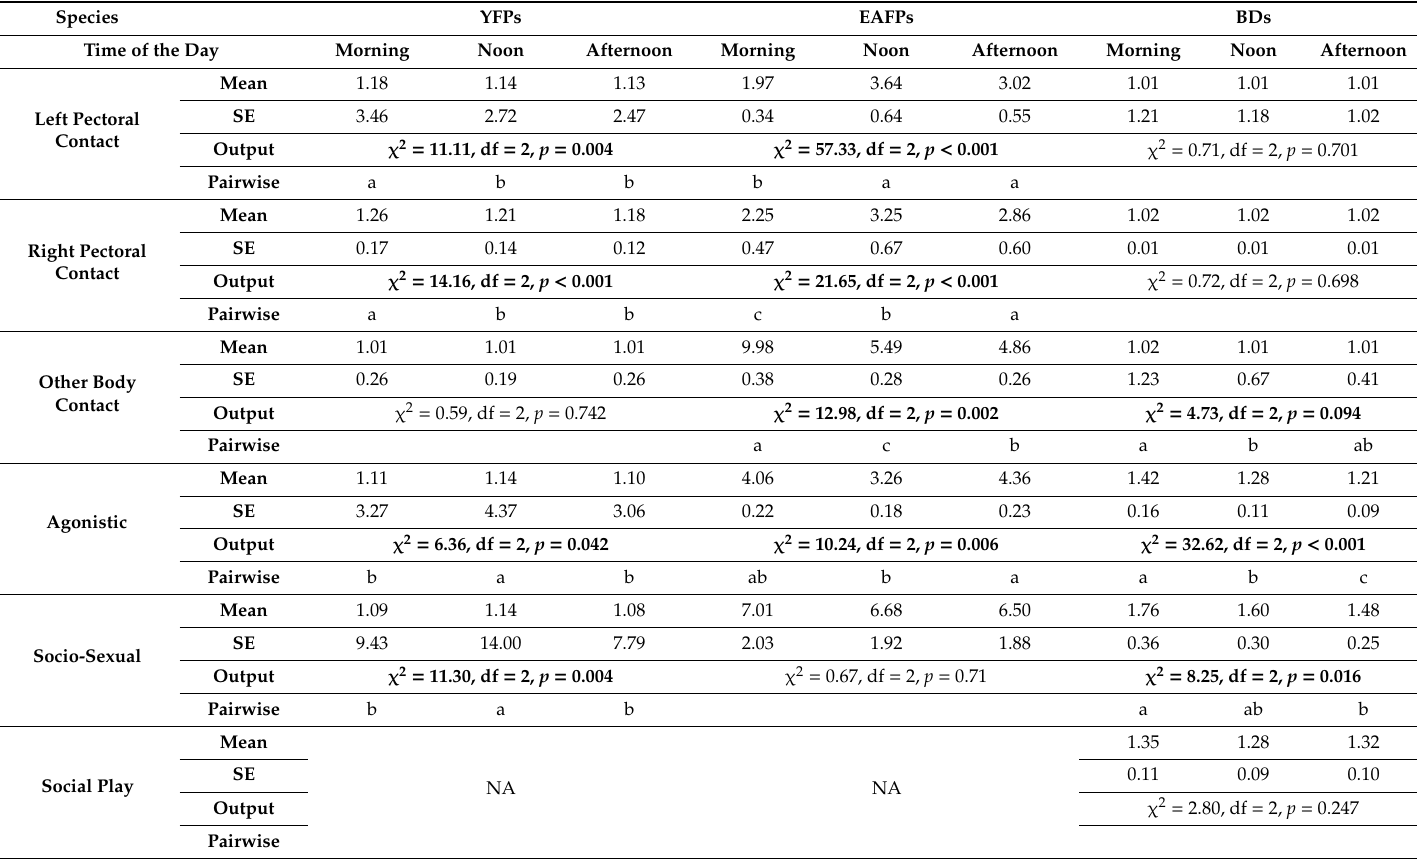
Table 4. Fitted means and standard errors of the frequency of each social behaviour depending on time of the day for Yangtze finless porpoises (YFPs), East-Asian finless porpoises (EAFPs) and bottlenose dolphins (BDs). Outputs come from Wald chi-squared tests run on Generalized linear mixed models, significant outputs are bolded. For each species and each behaviour, items sharing the same letter did not di ff er significantly, items that do not share the same letter di ff er significantly (post-hoc tests with sequential Bonferroni